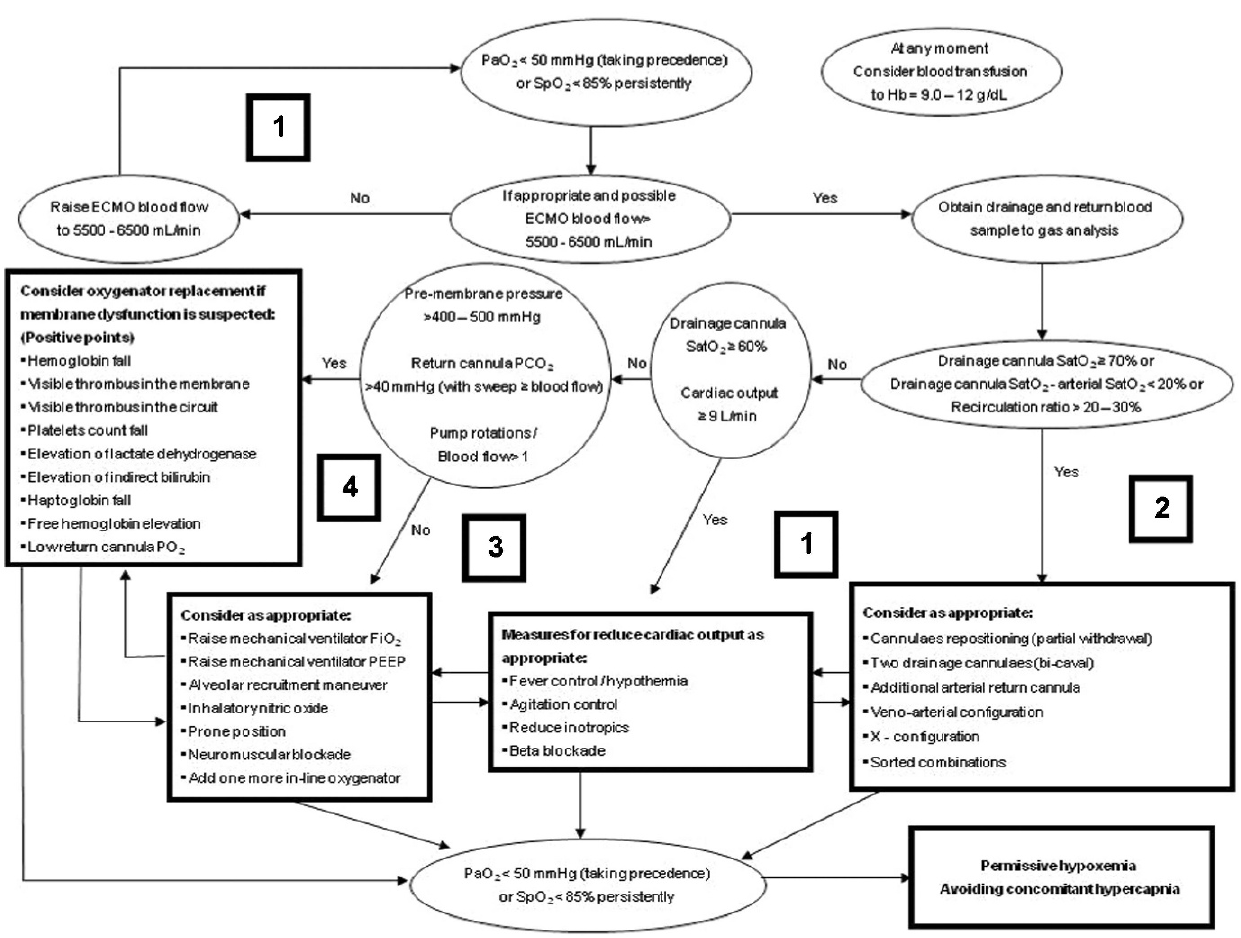
Figure 3- A stepwise approach for severehypoxemiaetiology diagnosis and resolution during VV-ECMO respiratory support. Possiblecauses of the persistent hypoxemia: 1. Blood flow/Cardiac output , 0.6. 2. Recirculation. 3. High pulmonary shunt. 4.